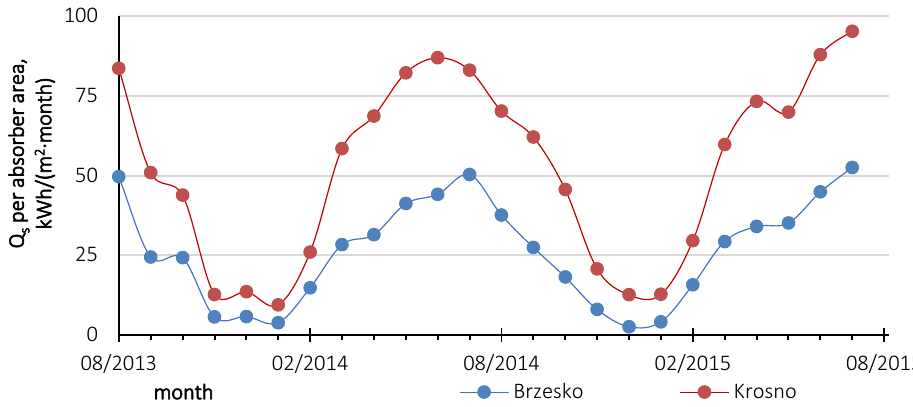
Figure 11. The comparison of solar heat gains per month ( Q s ) coming from the installations in Brzesko (FPCs) and Krosno (ETCs), calculated in reference to the absorber area. Table 3. Solar heat gain values coming from installations in Brzesko (FPCs) and Krosno (ETCs) obtained in the whole analyzed period (from 1 August 2013 to 31 July 2015) in reference to various area types.